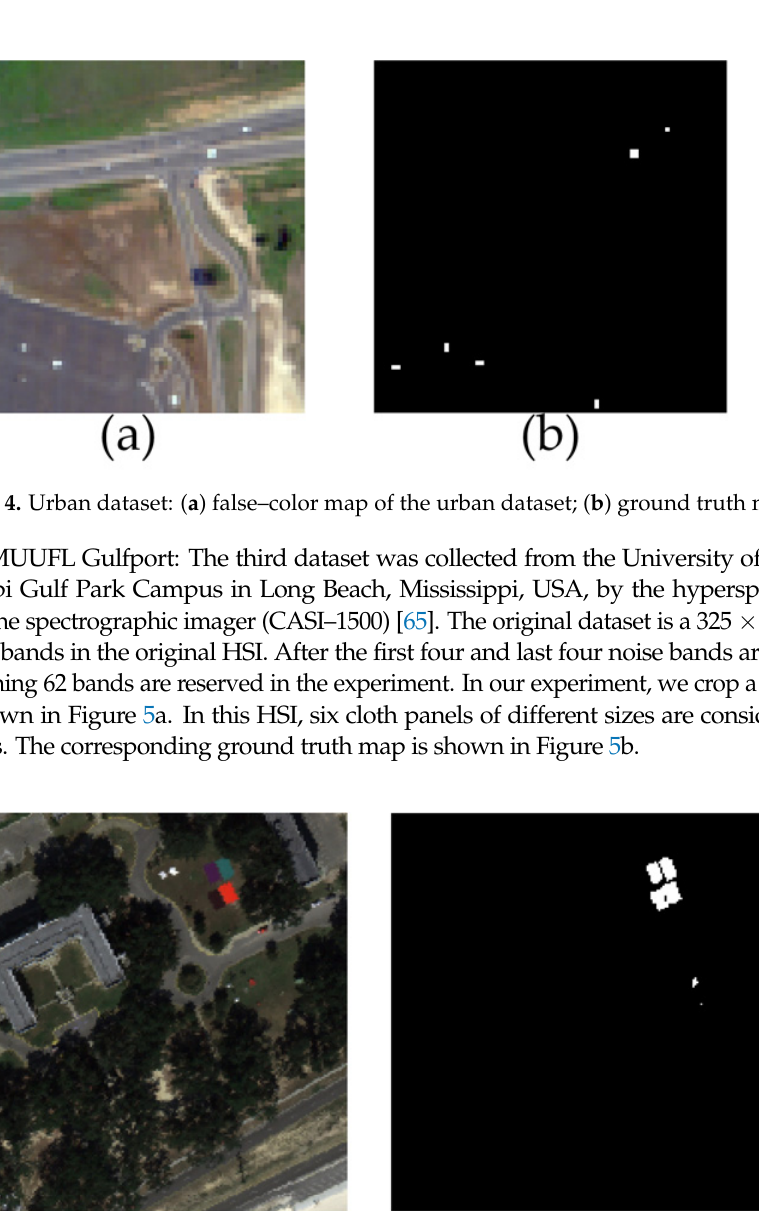
Figure 4. Urban dataset: ( a ) false–color map of the urban dataset; ( b ) ground truth map. MUUFL Gulfport: The third dataset was collected from the University of Southern